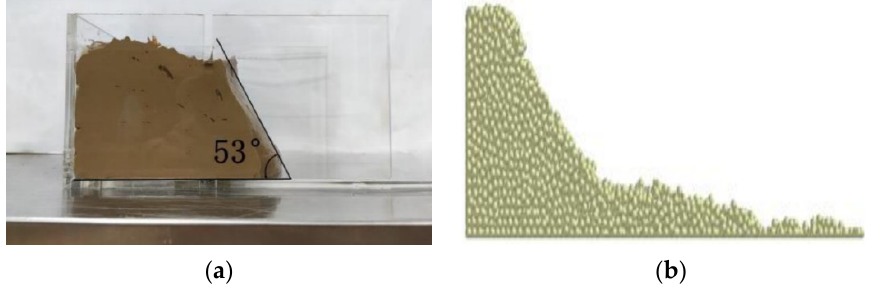
Figure 3. Experiment and simulation of measuring accumulation angle by sidewall collapse method. ( a ) Experiment; ( b ) Simulation [62].